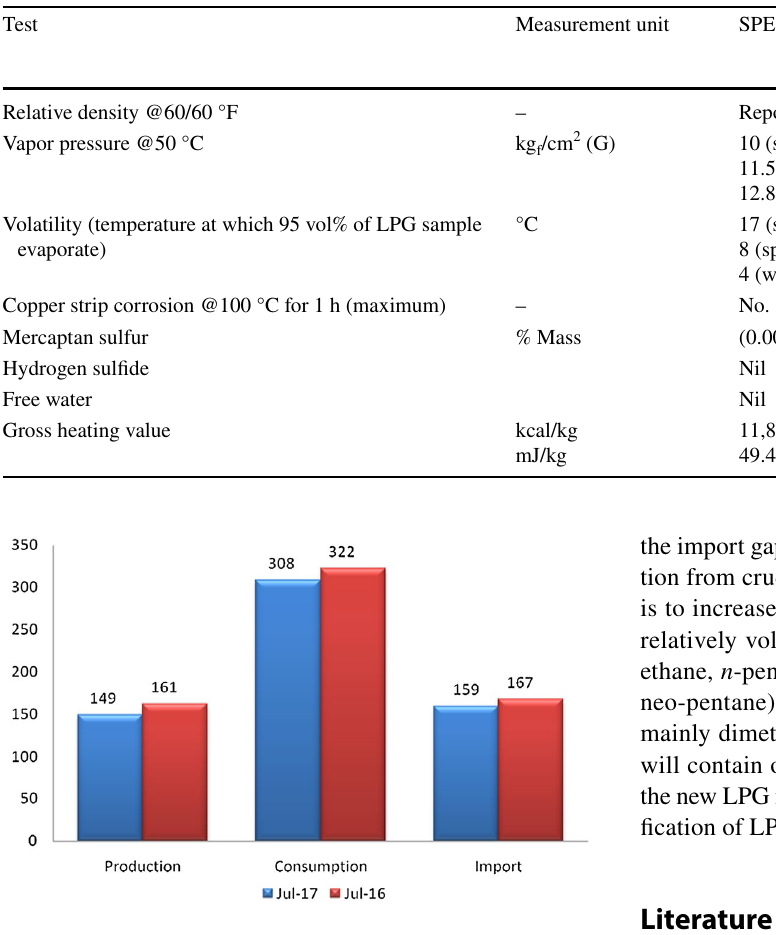
Fig. 1 LPG (in Mton) production, consumption and import in Egypt (Egyptian Central Agency for Public Mobilization and